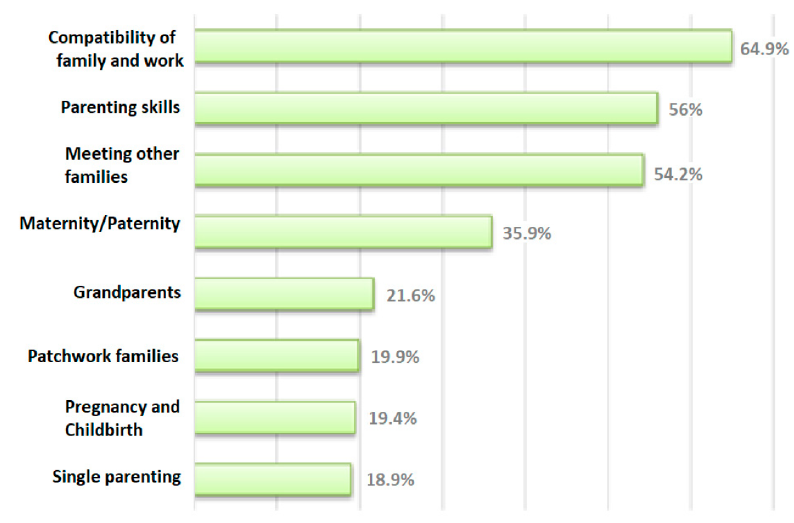
Figure 5. Subcategories of interest in parenting offers (percentage of all valid answers, multiple nominations). (Source: Authors,